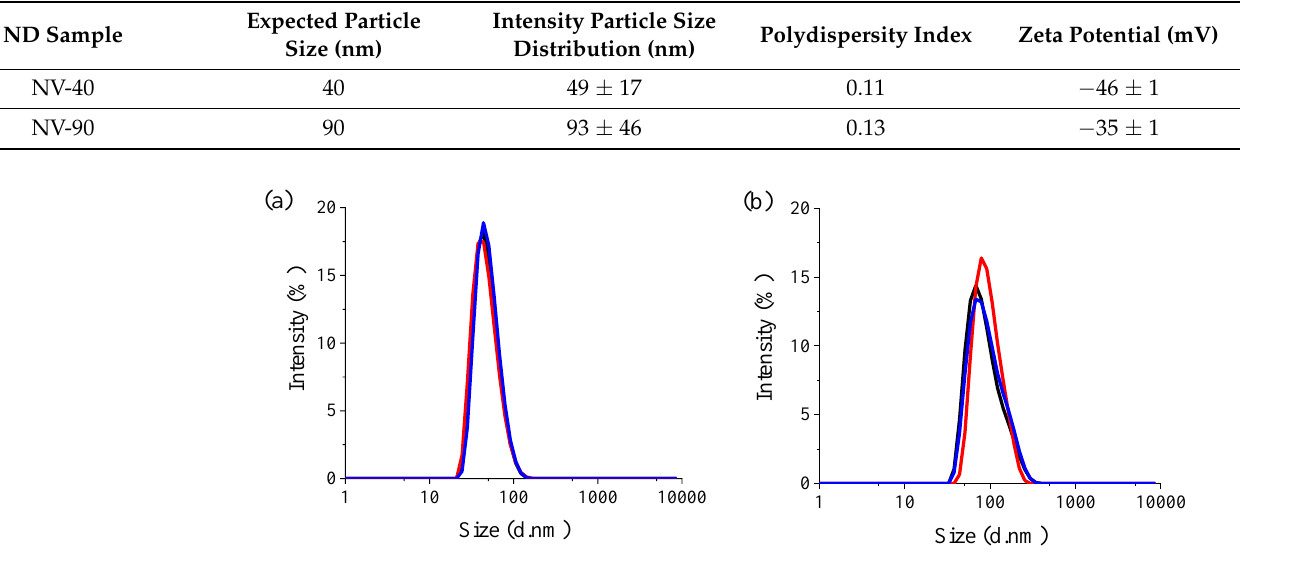
Figure 1. Volume particle size distribution of ( a ) NV-40 and ( b ) NV-90 NDs (0.1 mg/mL). The different colours represent 3 measurement scans with DLS.